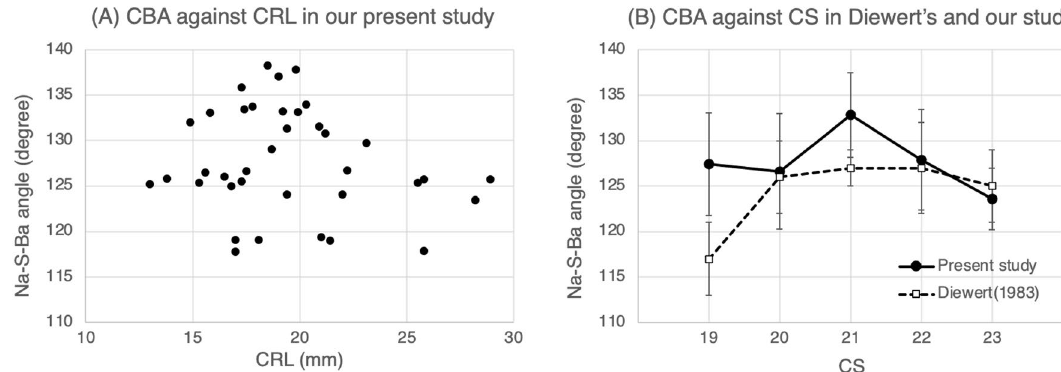
Figure 4. ( A ) Scatter plot of CBA against CRL. The distribution of each sample data has a high degree of variability. An approximate curve or line cannot be applied because of a low coefficient of determination for this scatter plot. ( B ) The mean and SD of CBA in both Diewert’s and our study are shown in the graph based on Table 4A. Our result shows an acute increment of CBA at CS21, whereas Diewert’s result shows flattening after CS20. Comparing only our present results in the two graphs, an acute increment of CBA at CS21 ( B ) fades away when it is against CRL ( A ). CBA, cranial base angle; CRL, crown-rump length; CS, Carnegie stage; SD, standard